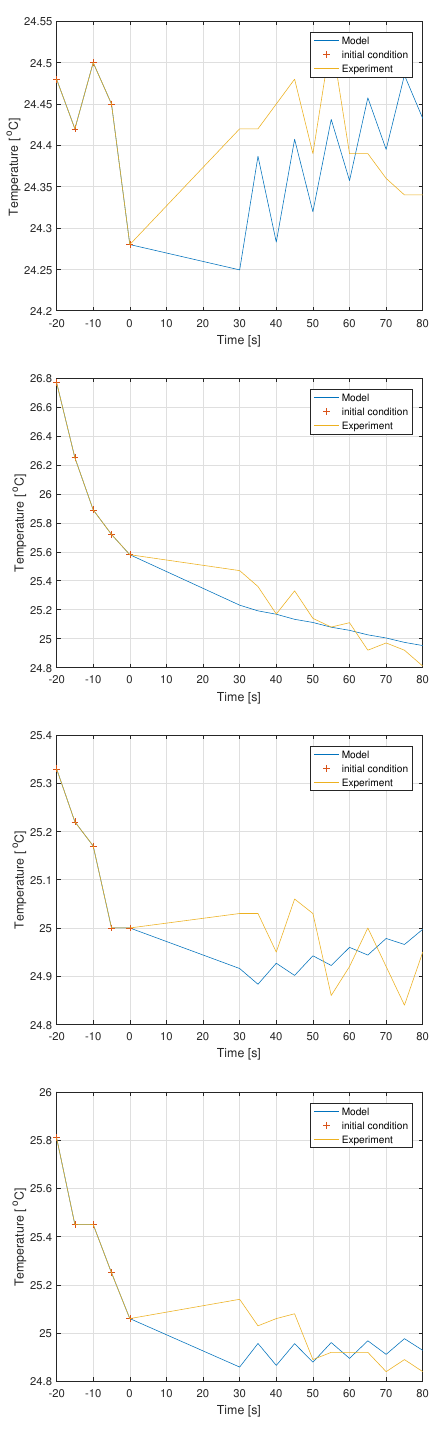
Figure 6. Comparison of responses of the FO model vs. the experiment for points (1— top )– (4— bottom